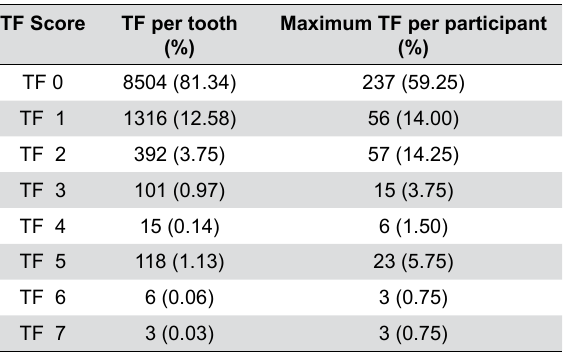
Table 1- Distribution of teeth and participants according to the levels of fluorosis considering the TF index